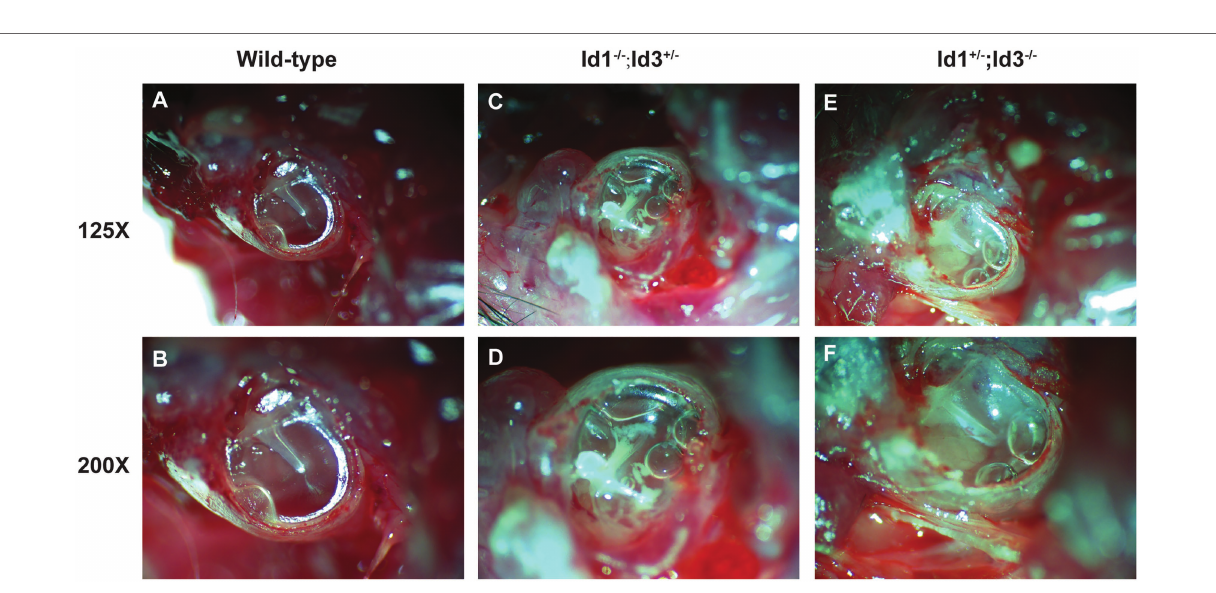
FIGURE 4 | Otoscopic examination of the middle ear in Id1 − / − ; Id3 +/ − and Id1 +/ − ; Id3 − / − mice. Compared with the middle ear cavities (MECs) of littermate control mice (A,B) , the MECs of Id1 − / − ; Id3 +/ − mice (C,D) and Id1 +/ − ; Id3 − / − mice (E,F) were filled with effusions, and white patches were observed on the tympanic membrane